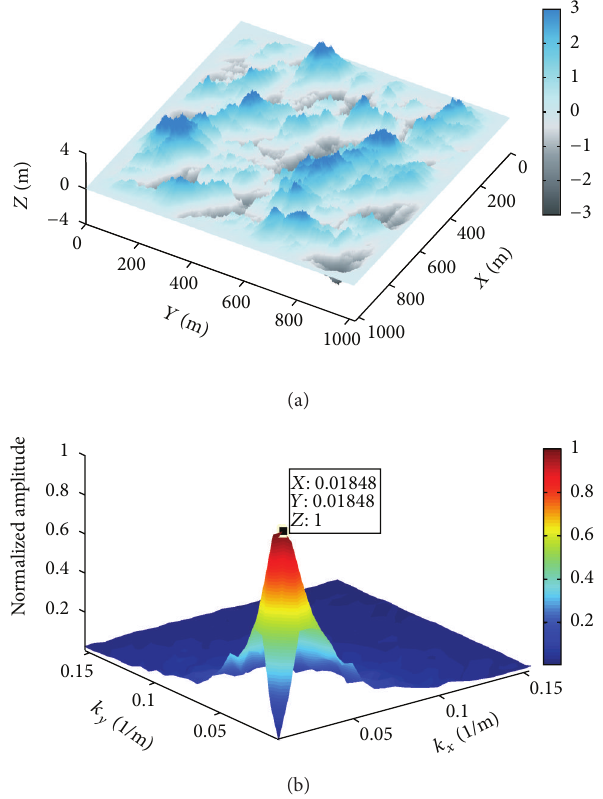
Figure 1: (a) A time frame of the time-varying directional Pierson- Moskowitz sea surface for a wind blowing with a speed of 17m/s at an angle of 45 ∘ between the positive 𝑥 - and 𝑦 -directions. (b) The ensemble averaged spectrum corresponding to the sea surface conditions shown in (a). The peak of the spectrum is indicated.